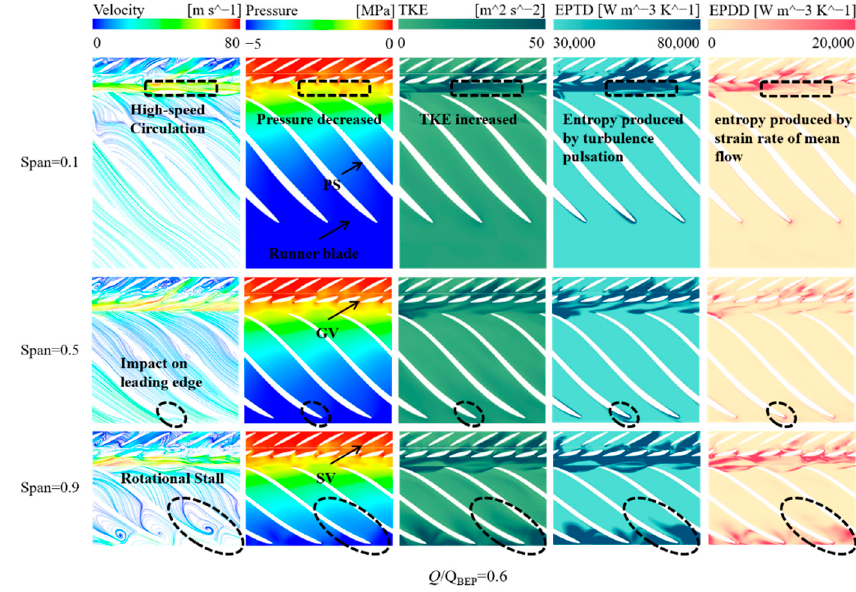
Figure 9. Distribution of entropy production under low-flow conditions (0.6Q BEP ).